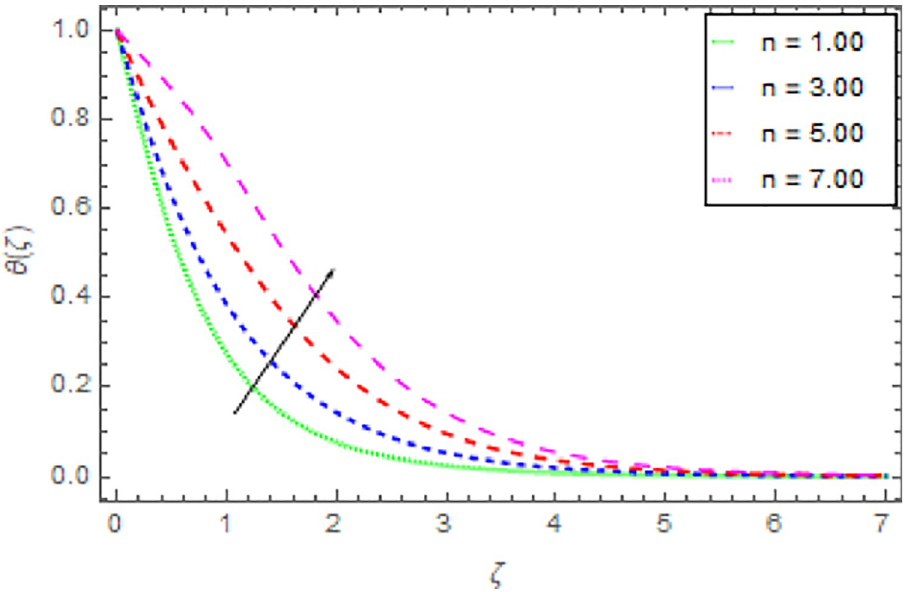
Fig 11. Deviation in nanofluid temperature against n when Pr = 1000, m = 0.10, n = 1.00, M = 2.50, δ = 0.40, β = 1.00, Nr = 0.20 and ϕ = 0.01 to ϕ =